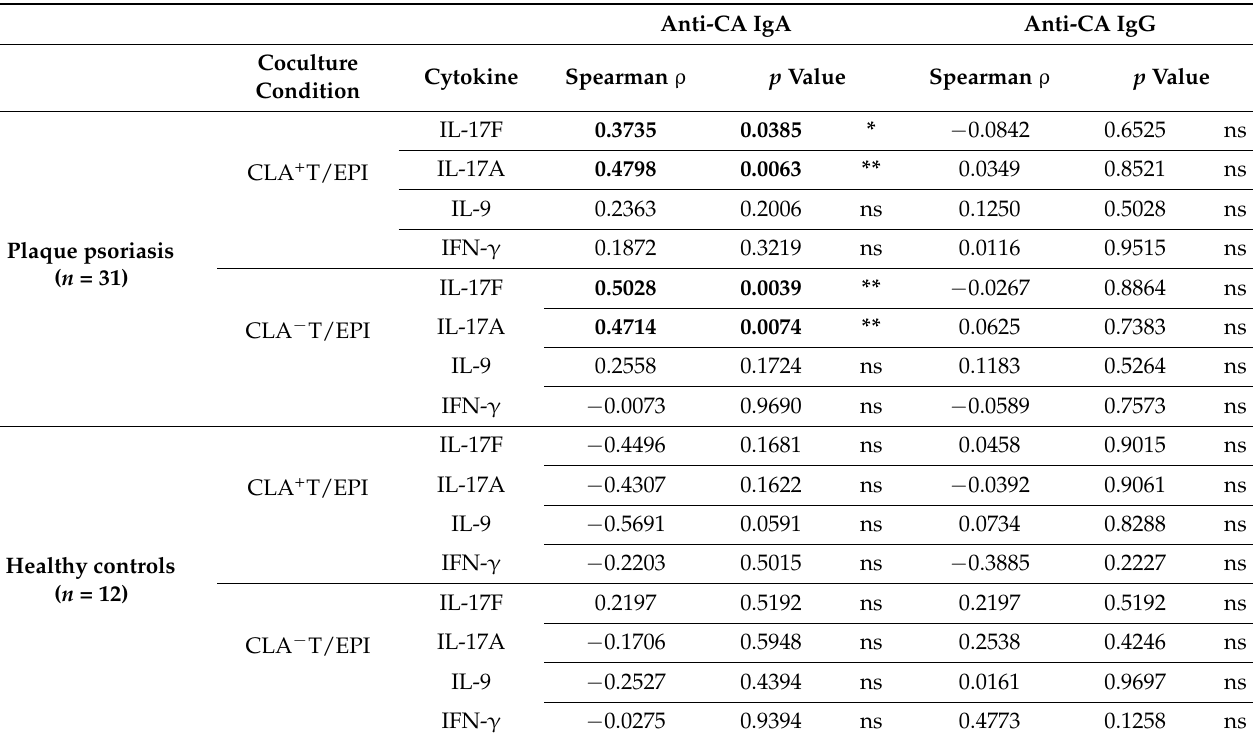
Table 2. Correlation of anti-CA IgA or IgG and cytokine responses to Candida albicans in CLA + or CLA − T cells cocultured with autologous epidermal cells. Spearman ρ and p values are indicated (ns: p > 0.05; *: p < 0.05; **: p <